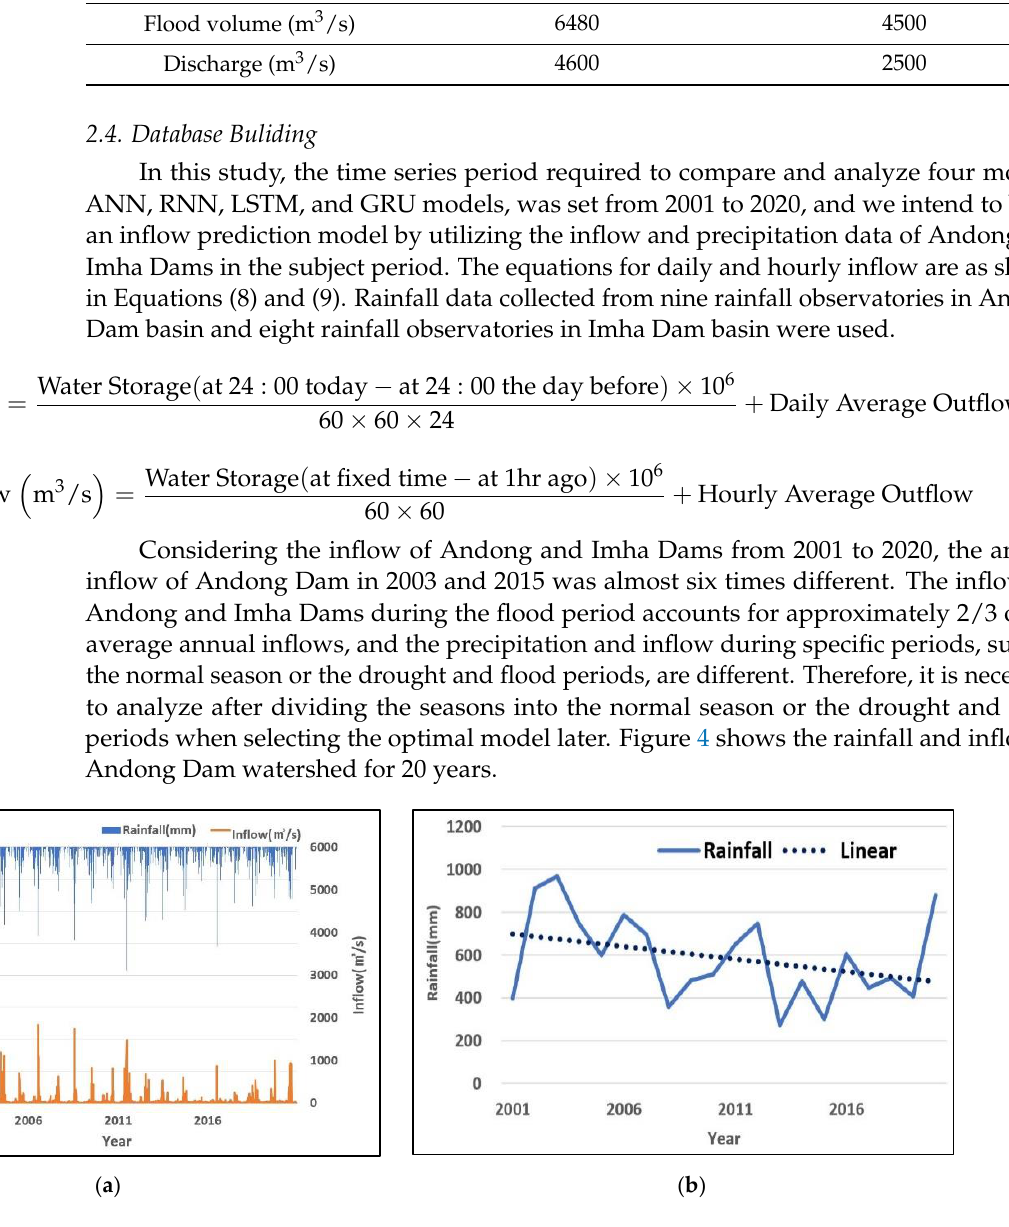
Figure 4. Inflow and rainfall at Andong Dam. ( a ) Inflow and rainfall for 2001 – 2020. ( b ) Rainfall